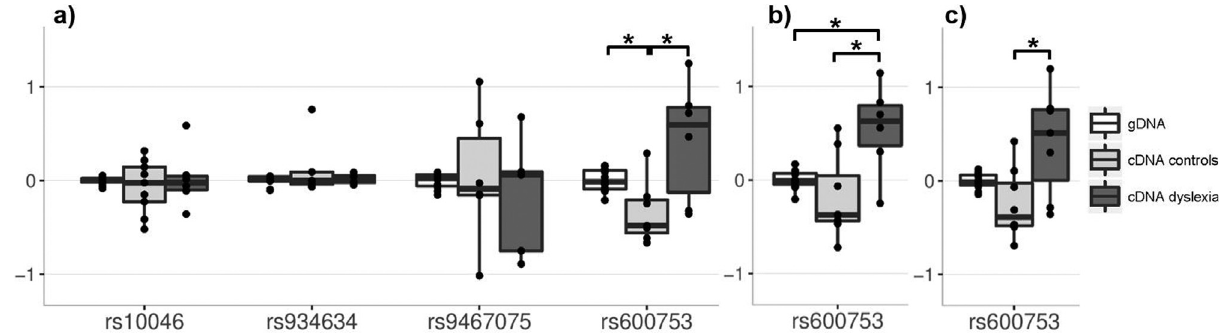
Figure 3 - Differential allelic expression (DAE) of four dyslexia-related SNPs. Shown are allelic log-ratios measured in heterozygous samples adjusted for the gDNA allelic ratio. a) Forward sequencing analysis of all four expressed SNPs stratified for cDNA allelic ratios for controls and the dyslexia af- fected family and the logarithm of the gDNA allelic ratio. b) Reverse sequencing based replication of rs600753. c) Analysis of both sequencing ap- proaches together. * p < 0.05 (Wilcoxon rank sum test). Global testing for genetic effects on gene expression of rs600753- DYX1C1 applying Kruskal-Wallis test was always p < 0.05. For details see Table 1.